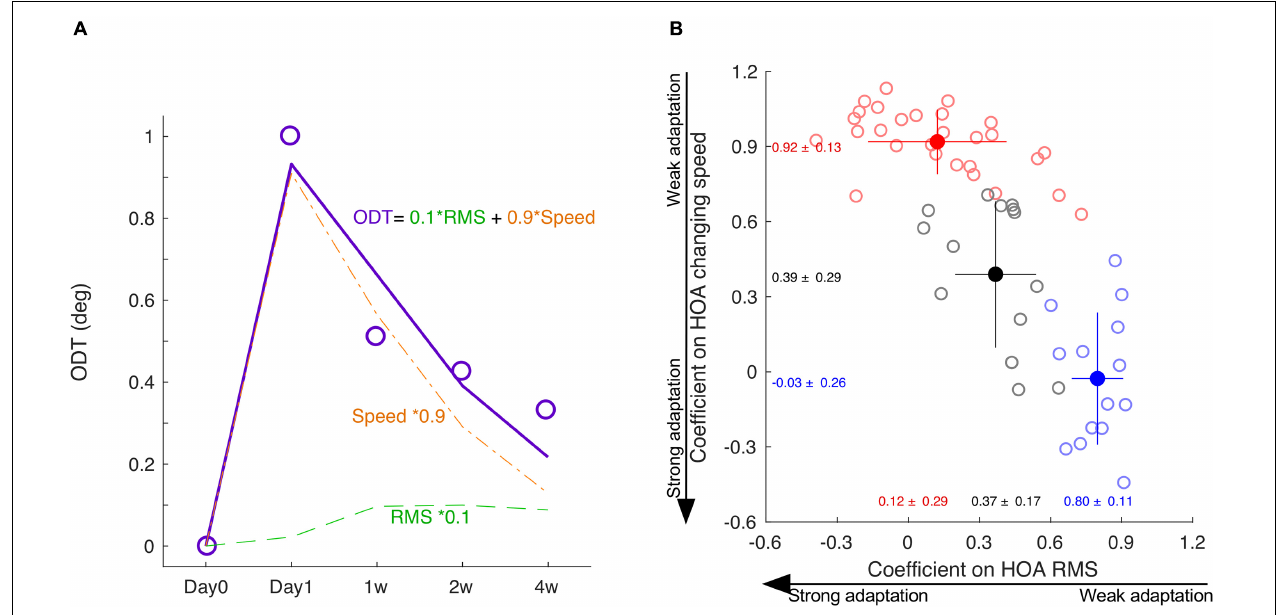
FIGURE 6 | The decomposition of ODT time course. (A) The ODT time course is decomposed as a linear combination of the time courses of HOA-RMS and HOA changing speed. (B) The distribution of coefficients of subjects peaked at day 1 (red), day 7 (black), and at or after day 14 (blue). SPD, speed. * means multiplication.